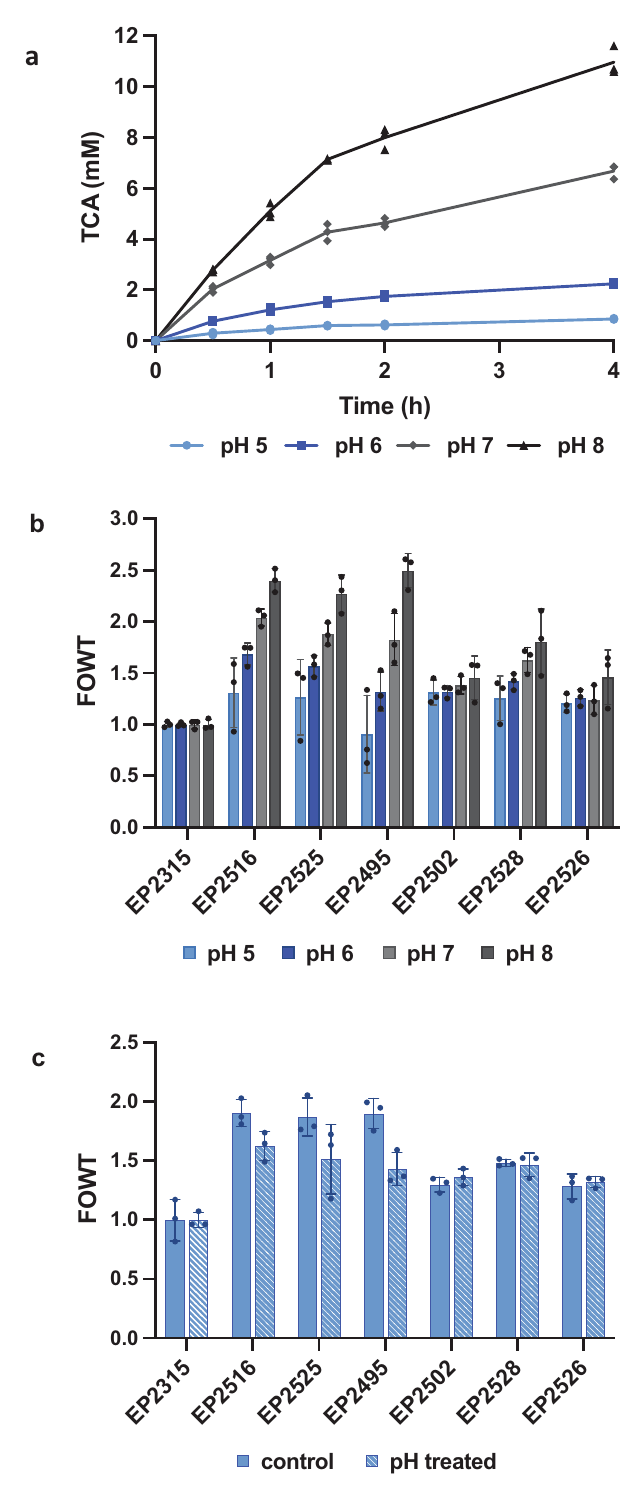
Fig. 4 Activity at different pH or after exposure to low pH. a Whole-cell TCA production for EcN with wild-type StlA after 0.5 h, 1 h, 1.5 h, 2 h, or 4 h at pH 5, 6, 7, or 8. n = 3 biological replicates with individual data points shown. b Whole-cell PAL activity after 4 h at pH 5, 6, 7, or 8, normalized to wild-type StlA activity (fold over wild-type, FOWT). n = 3 biological replicates ± s.d. c Whole-cell PAL activity after 4 h at pH 7, assayed without pH treatment (control) or